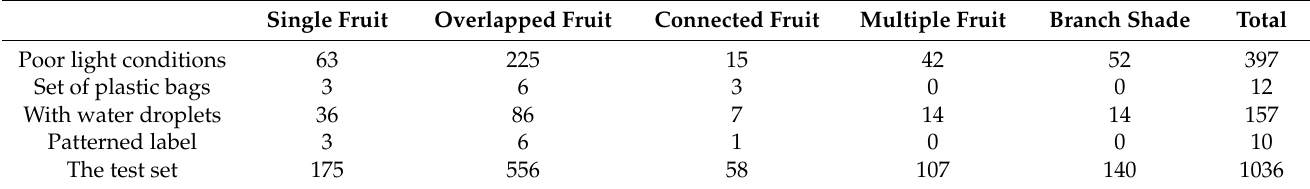
Table 1. Class information for the test data